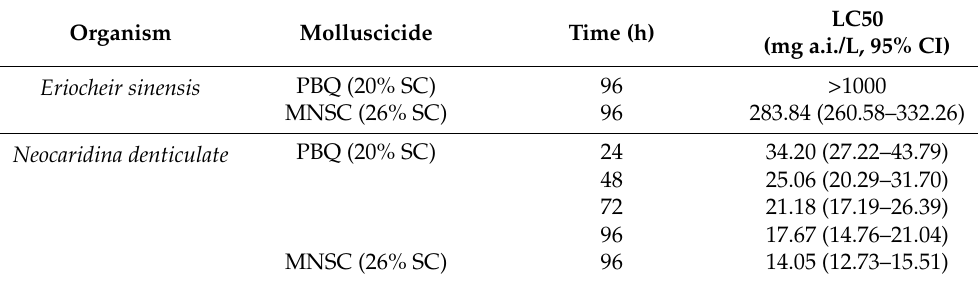
Table 5. Acute toxicity of PBQ against Eriocheir sinensis and Neocaridina denticulate